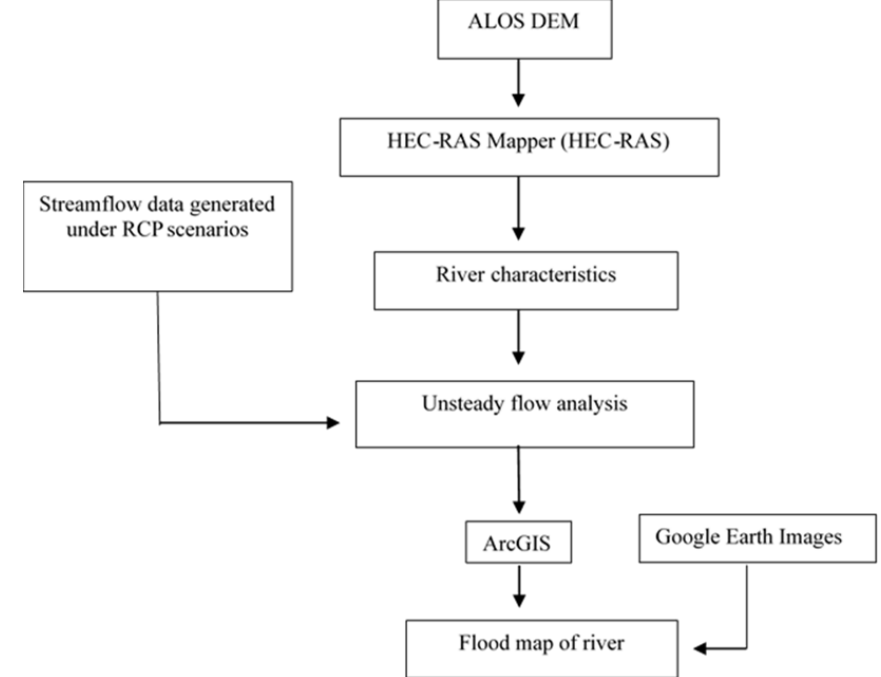
Figure 4. Methodology flowchart for HEC-RAS mapping.